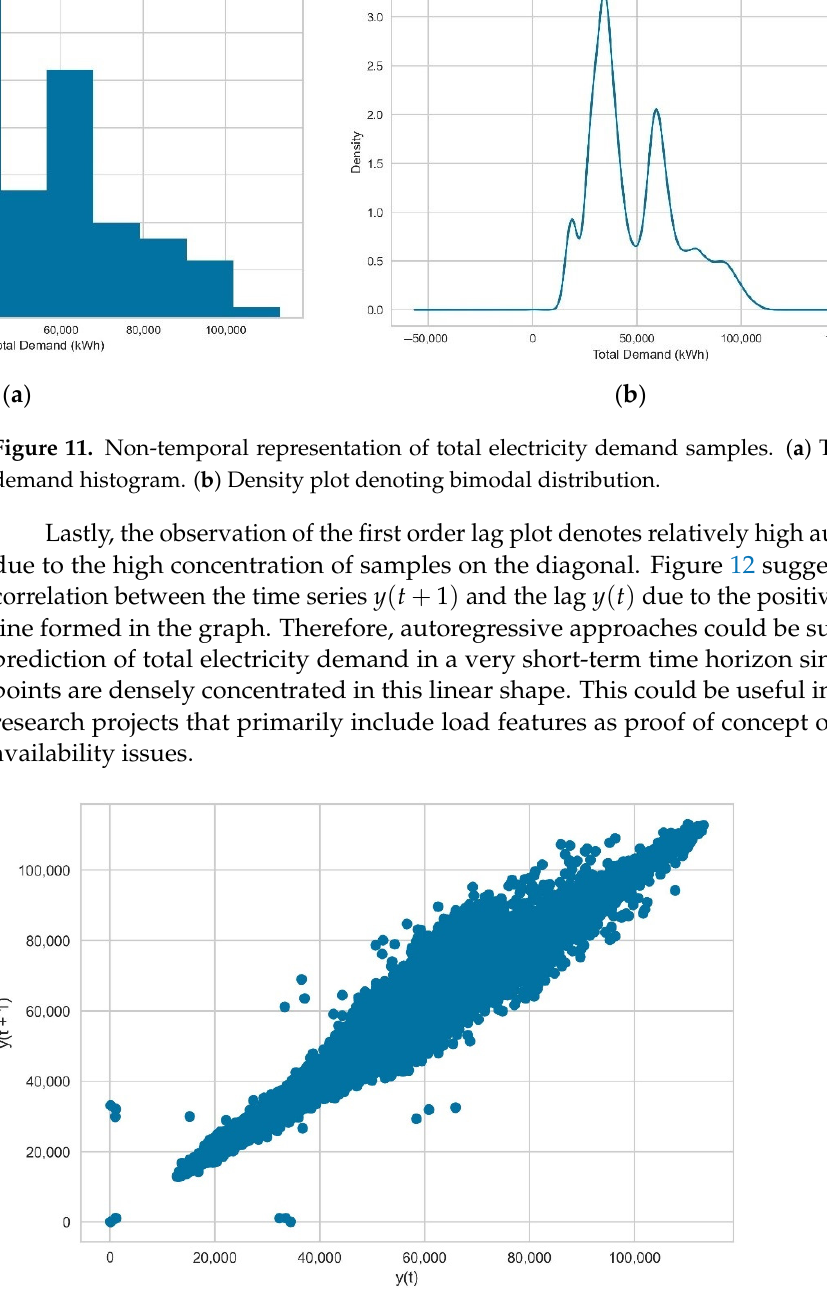
Figure 12. First order lag plot comparing total electricity demand time series y ( t + 1 ) to the lagged total demand y ( t ) .